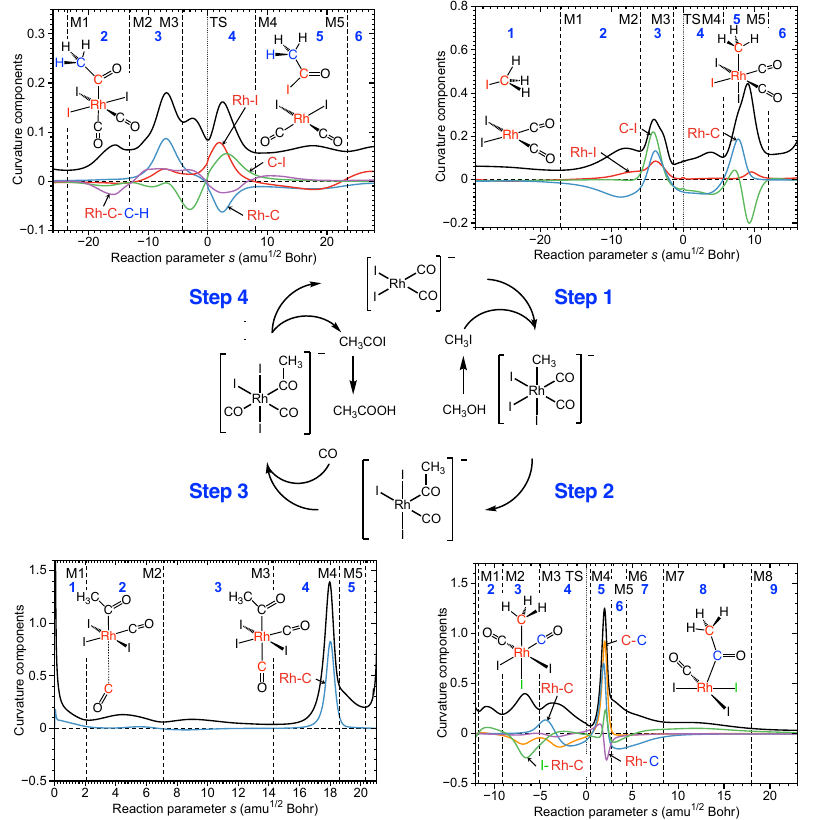
Figure 2. The reaction cycle of methanol carbonylation catalyzed by [Rh(CO) 2 I 2 ] − consisting of four steps: 1 —oxidative addition; 2 —migration of the methyl group; 3 —insertion of carbon monoxide; 4 —reductive elimination [144,145]. For each step the reaction curvature as a function of the reaction path parameter s (solid black line) and its decomposition into the most important curvature components (colored lines) are shown. The borders of the reaction phases are indicated by vertical dashed lines at curvature minima M1, M2, M3, etc. The reaction phases are indicated by blue numbers. The TS at s = 0 amu 1/2 Bohr is also indicated by a vertical dotted line. B3LYP/6-31G(d,p)/SDD level of